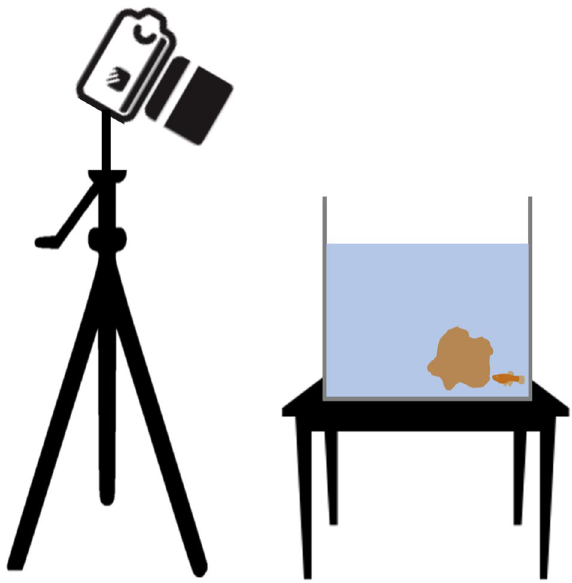
Figure 5. Fish were observed in a 10 L tank that contained only a rock with a diameter of 6.93 cm on its widest. The rock used was beige, similar to twoline skiffias’ and guppies’ predominant colour. Recordings were made with a camera placed at 30° from the top of the tank in order to see the fish at all